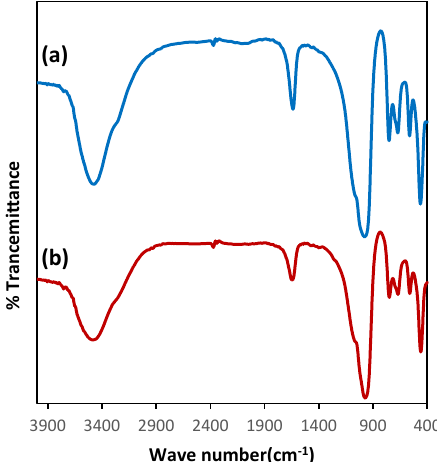
Fig. 4. FT-IR spectrum of (a) the Zeolite 13X; (b) Ag NPs/Zeolite 13X nanocomposite Fig. 4 FT-IR spectrum of (a) the Zeolite 13X; (b) Ag NPs/Zeolite 13X nanocomposite samples .